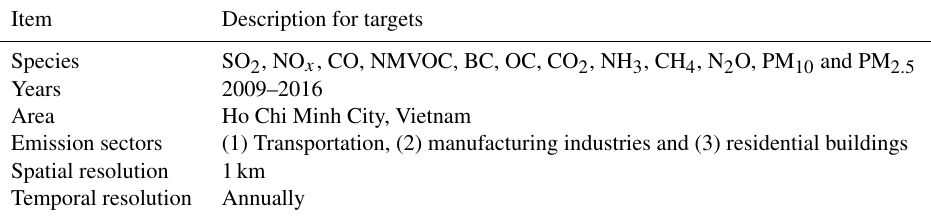
Table 2. General information on HCMC emission inventory.